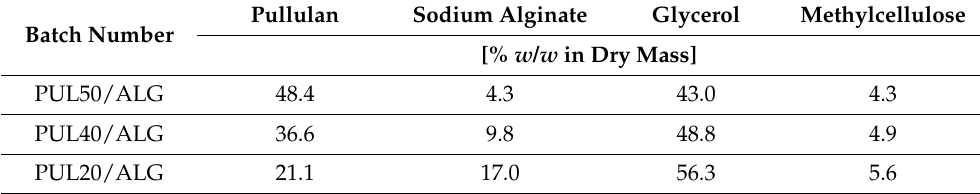
Figure 2. Optical images of porous matrices (picture taken with Nikon S9300 camera using macro lens). Table 2. Porous matrices composition for triamcinolone